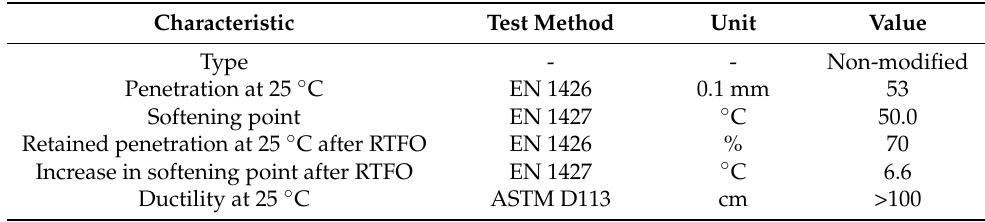
Table 1. Physical properties of bitumen utilized for mixtures.